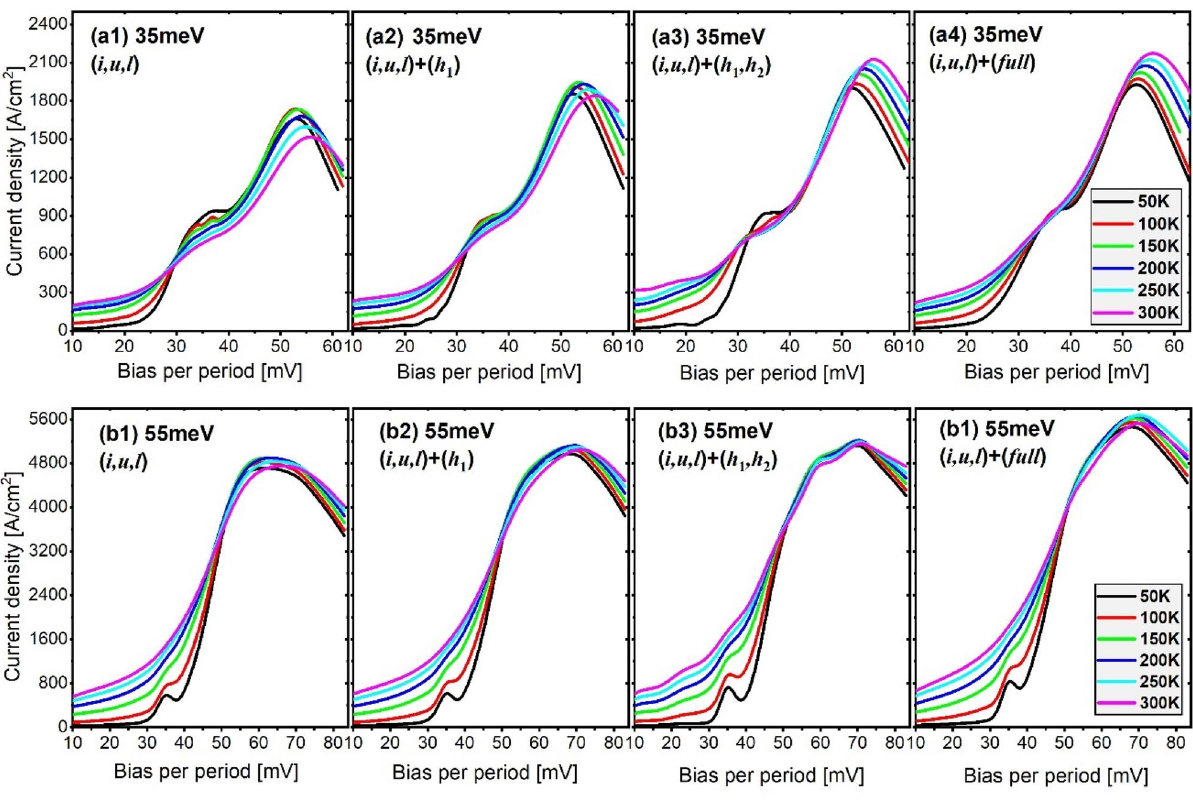
Figure 2. Current–voltage curves at different temperatures as a function of the applied bias for both the 35 meV design ( a1 – a4 ) and 55 meV design ( b1 – b4 ). Each fig represents the curves at different level